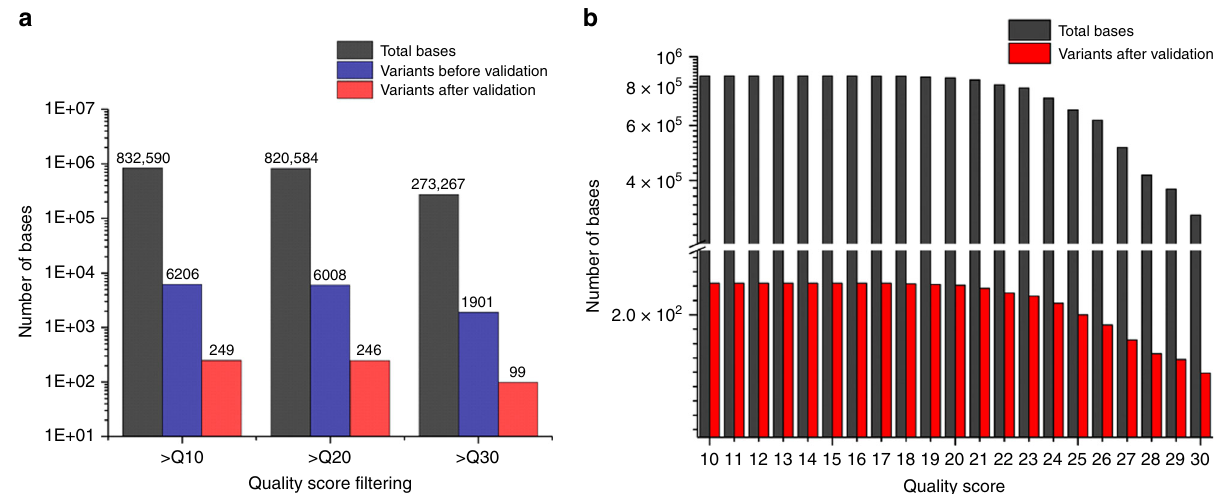
Fig. 5 Identi fi cation of true variants reduction by quality control through the barcode-free NGS error validation. a Comparison of variants after fi ltering raw data with the Q-score (>Q10, >Q20, and >Q30). Variants before the NGS error validation were reduced (3.26 times less) more than variants after validation (2.48 times less), which might include low Q-score of variant calls. b Reduction of true variants by quality control from >Q10 to >Q30. From Q- score over than 18, the true variants were con fi rmed to decrease by the barcode-free NGS error validation. Source data are provided as a Source Data fi